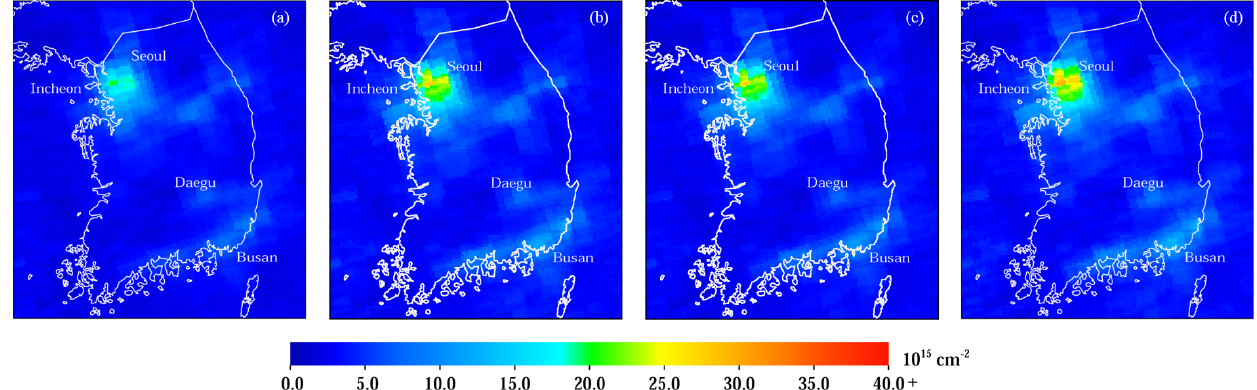
Figure 11. (a) The OMI-standard product during the month of May 2016, (b) the OMI-regional NO 2 product with the WRF-Chem air mass factor adjustment and spatial kernel during the same period, (c) same as (b) but using WRF-Chem NO 2 profiles scaled based on the aircraft comparison, and (d) same as (b) but using the WRF-Chem simulation with NO x in the Seoul metropolitan area emissions increased by a factor of